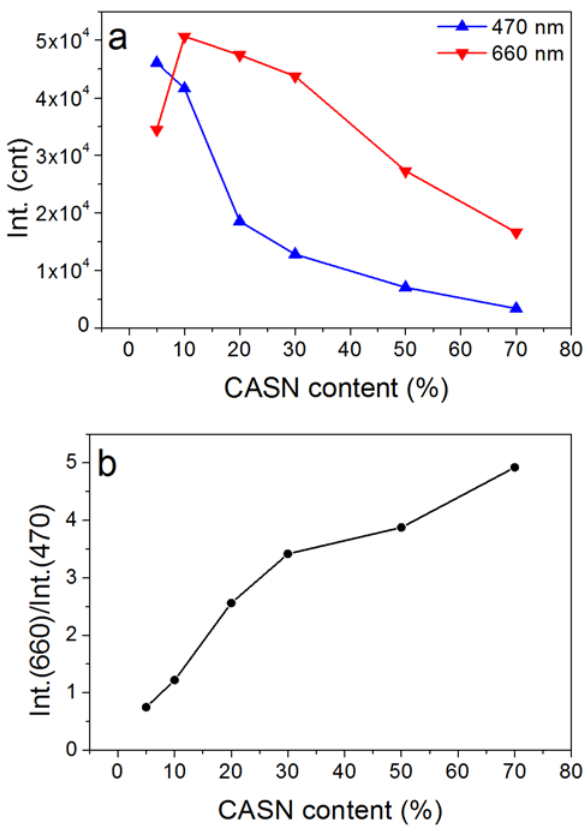
Figure 6. Influence of CASN content on the intensity ( a ) and red/blue emission ratios ( b ) (Int.(660 nm) vs. Int.(470 nm)) of the nanocomposite films.